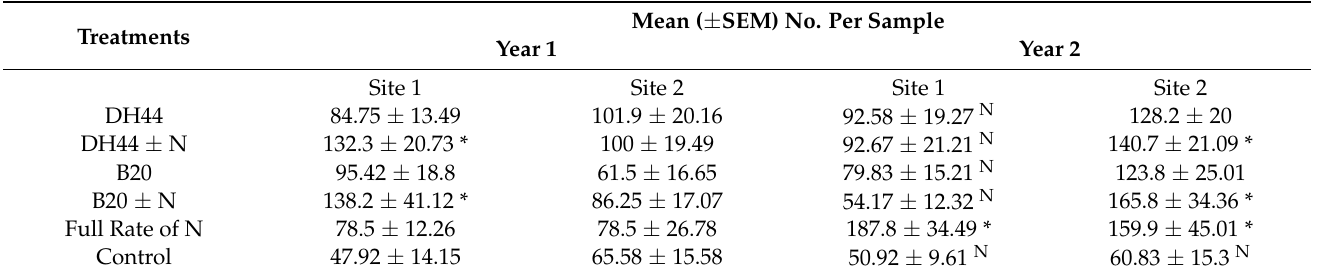
Table 2. Abundance of mesostigmatids mites collected from bermudagrass forage plots treated with conventional fertility or